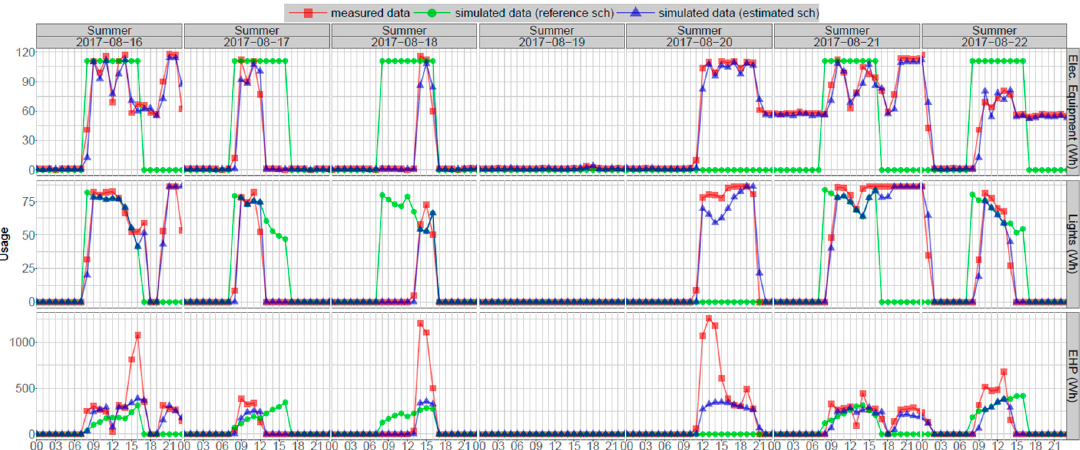
Figure 11. Comparison results of the energy simulation using the reference and estimated schedules against the measured electricity consumption for 16 August 2017~22 August 2017.